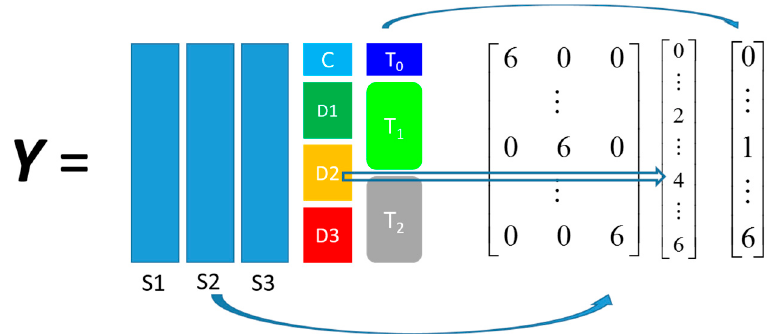
Figure 2. Structured output coding for the propranolol set, For example, a sample of S1, D2, and T2 would be coded as [6 0 0 4 6].